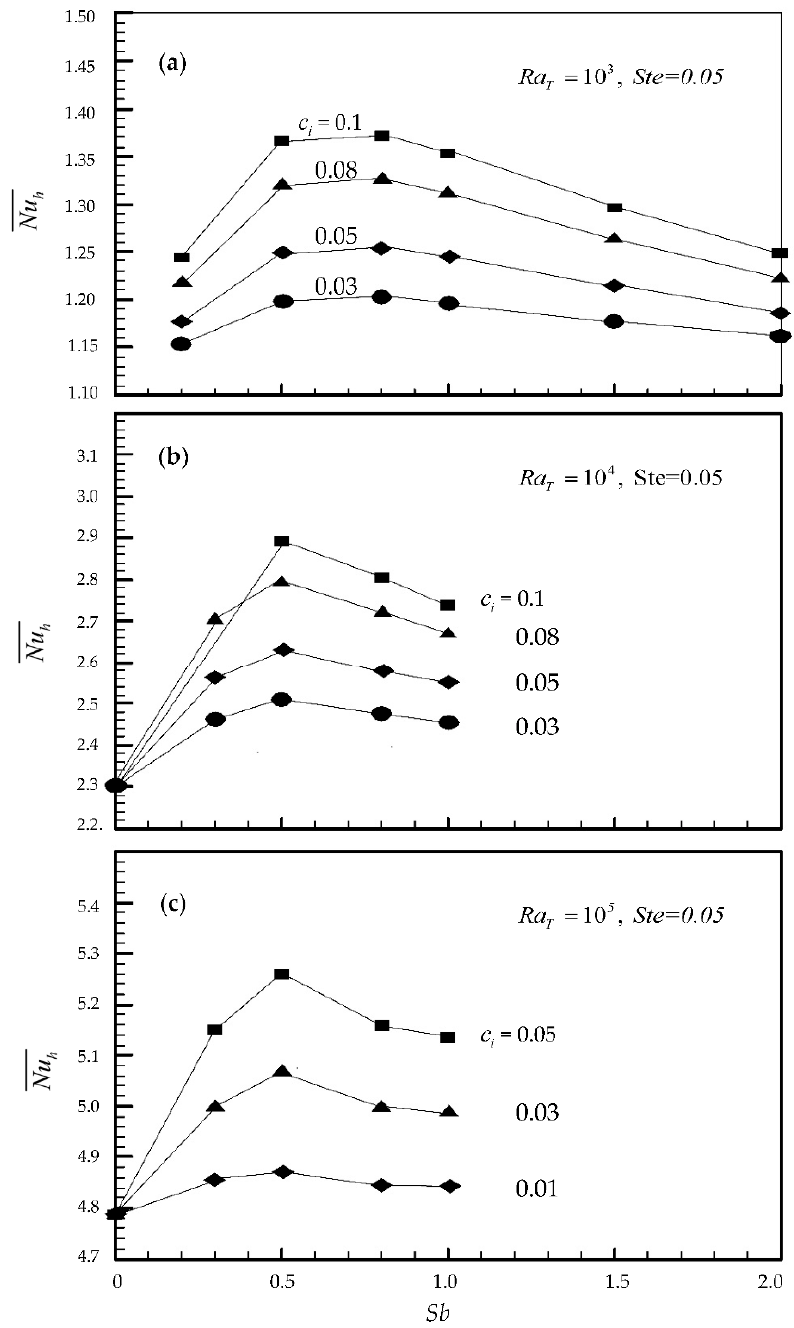
Figure 6. The effect of Sb on the average Nusselt numbers of the hot walls. (( a ): Ra T = 10 3 , Ste = 0.05, ( b ): Ra T = 10 4 , Ste = 0.05, ( c ): Ra T = 10 5 , Ste = 0.05